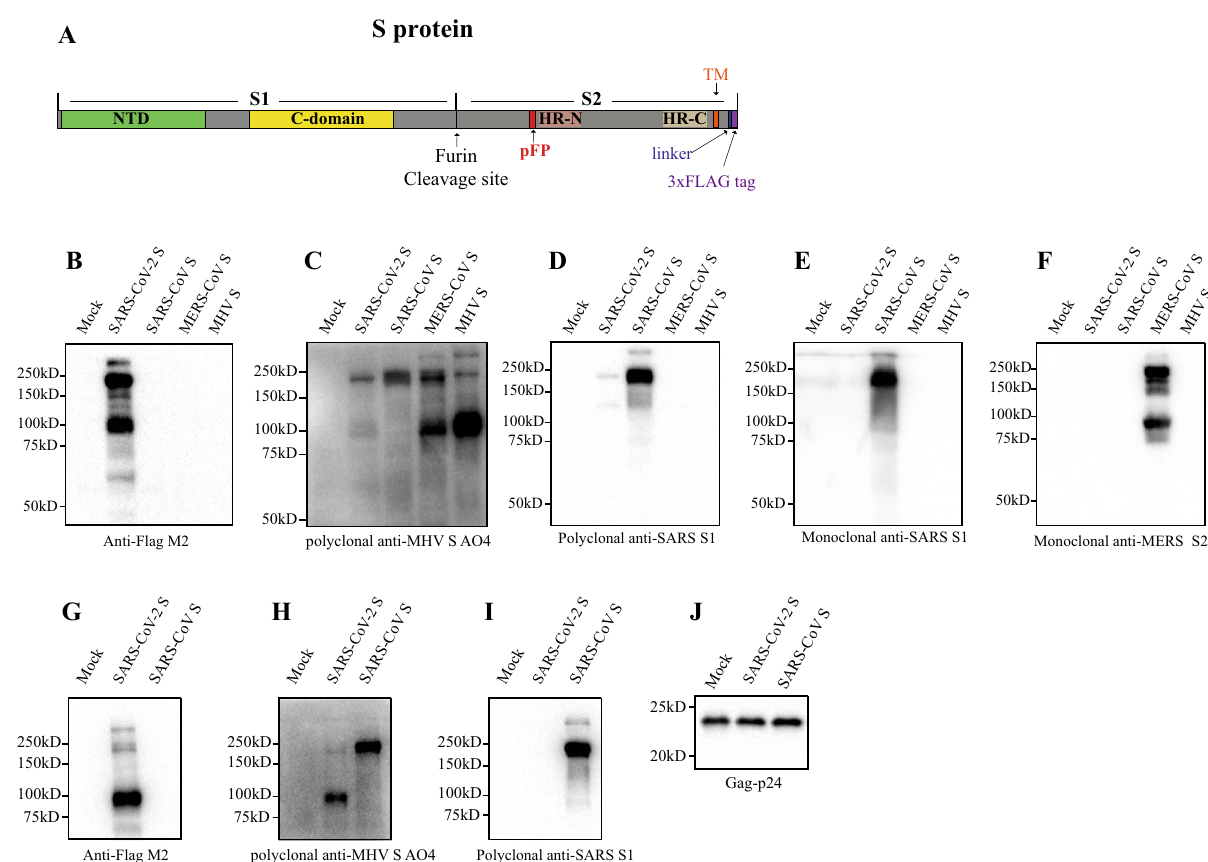
Fig. 1 Incorporation of SARS-CoV-2 S protein into pseudovirions. a Diagram of full-length SARS-CoV-2 S protein with a 3xFLAG tag. S1, receptor-binding subunit; S2, membrane fusion subunit; TM, transmembrane domain; NTD, N-terminal domain; pFP, potential fusion peptide; HR-N, heptad repeat-N; HR-C, heptad repeat-C; b – f Detection of CoVs S protein in cells lysate by western blot. Mock, 293T cells transfected with empty vector. b Mouse monoclonal anti-FLAG M2 antibody; c Polyclonal goat anti-MHV-A59 S protein antibody AO4. d Polyclonal rabbit anti-SARS S1 antibodies T62. e Mouse monoclonal anti-SARS S1 antibody. f Mouse monoclonal anti-MERS-CoV S2 antibody. g – j Detection of CoVs S protein in pseudovirions by western blot.Gag- p24 served as a loading control. g Anti-FLAG M2. h Polyclonal goat anti-MHV-A59 S protein antibody AO4. i Polyclonal rabbit anti-SARS S1 antibodies T62. j Polyclonal anti-Gag-p24 antibodies. uncleaved S protein, about 180 kDa; cleaved S protein, about 90 kDa. Experiments were done twice and one is shown. Source data are provided as a Source Data fi